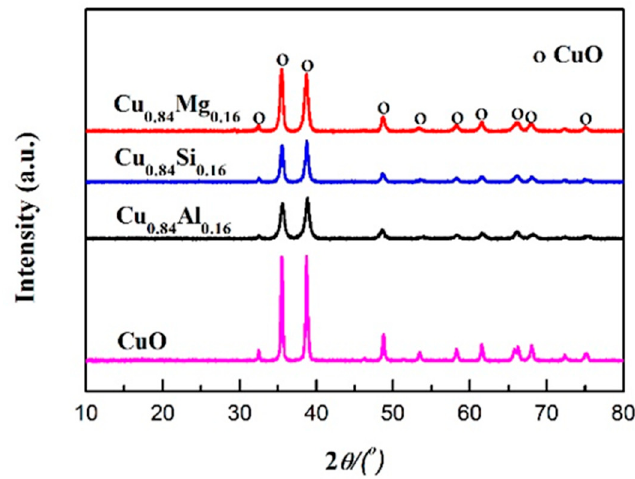
Figure 1. X-ray diffraction (XRD) patterns of the catalysts. Figure 1. X-ray di ff raction (XRD) patterns of the